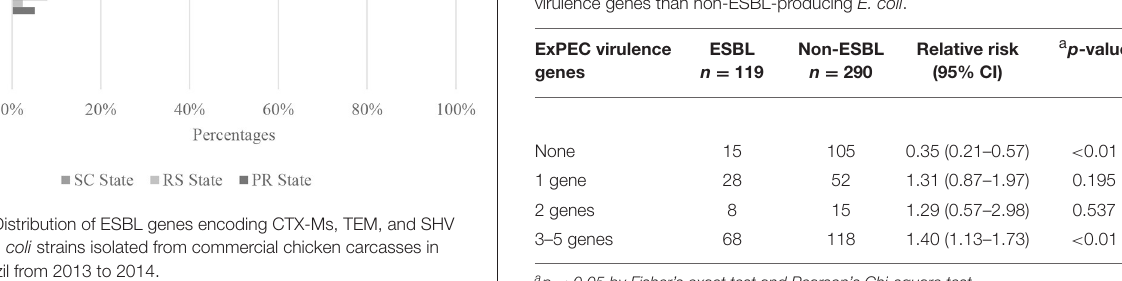
TABLE 3 | Risk factor analysis indicating that ESBL-producing E. coli harbor more virulence genes than non-ESBL-producing E. coli .